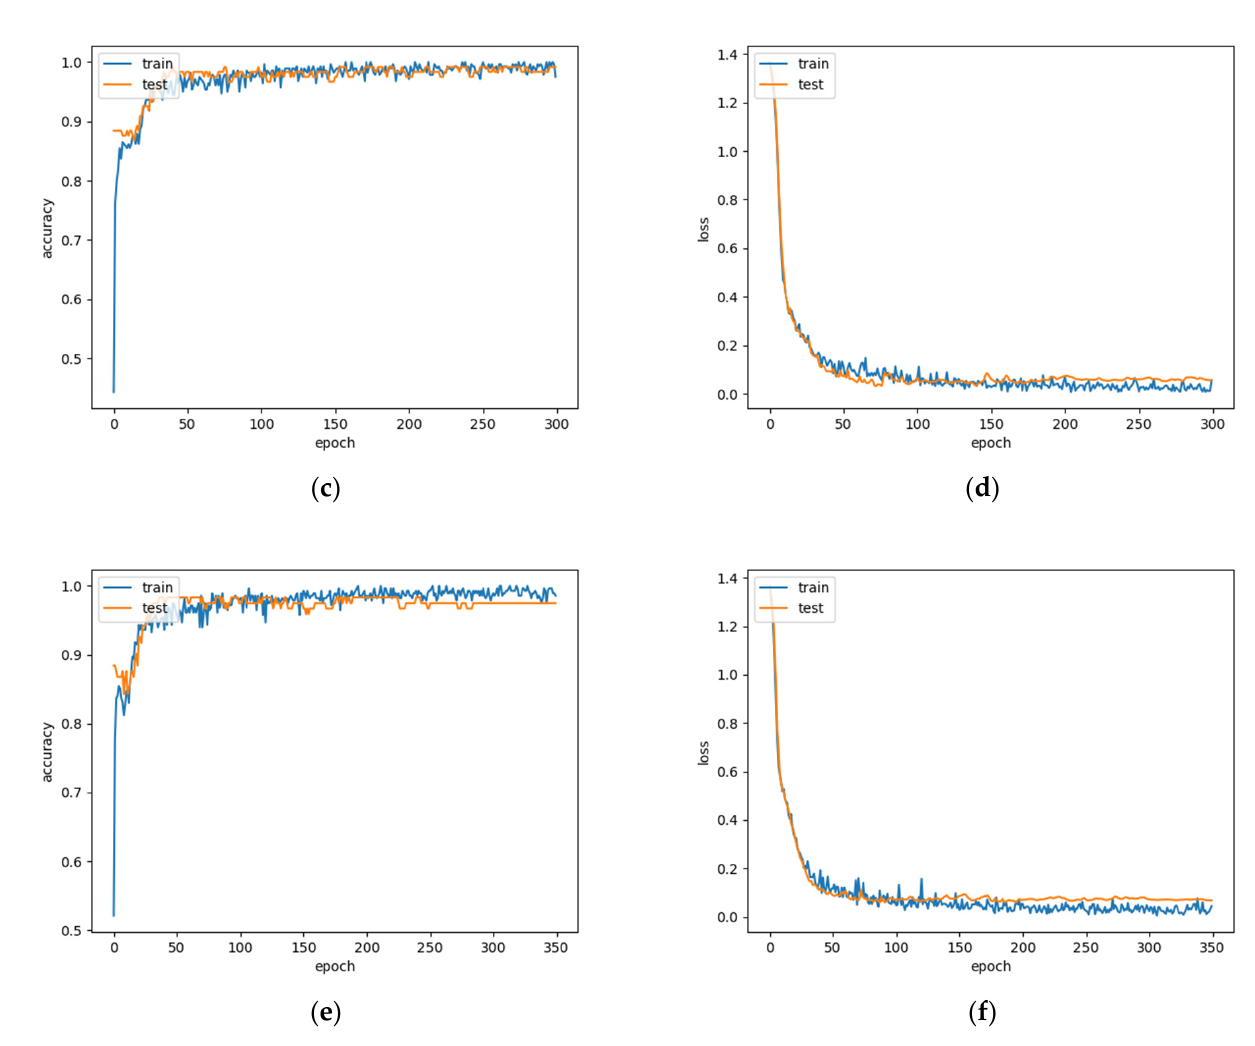
Figure 7. Accuracy and loss for boys’ physical fitness level evaluation. ( a , b ) Accuracy and loss when epoch is 250; ( c , d ) Accuracy and loss when epoch is 300; ( e , f ) Accuracy and loss when epoch is 350.